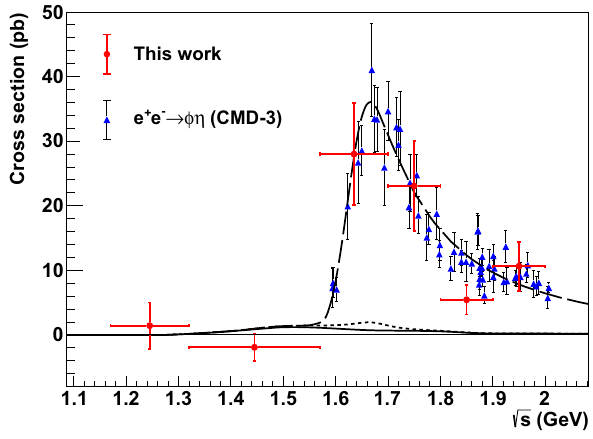
Fig. 2 The the e + e − → ηηγ Born cross section measured in this work (circles) compared with the e + e − → φη cross section measured by CMD-3 in the decay mode φ → K + K − [4] multiplied by the branching fraction of the decay φ → ηγ (triangles). The solid curve is the e + e − → ρη cross section, the dotted curve is the sum of the e + e − → ρη and ωη cross sections, while the dashed line is the sum of the e + e − → φη , ρη and ωη cross sections